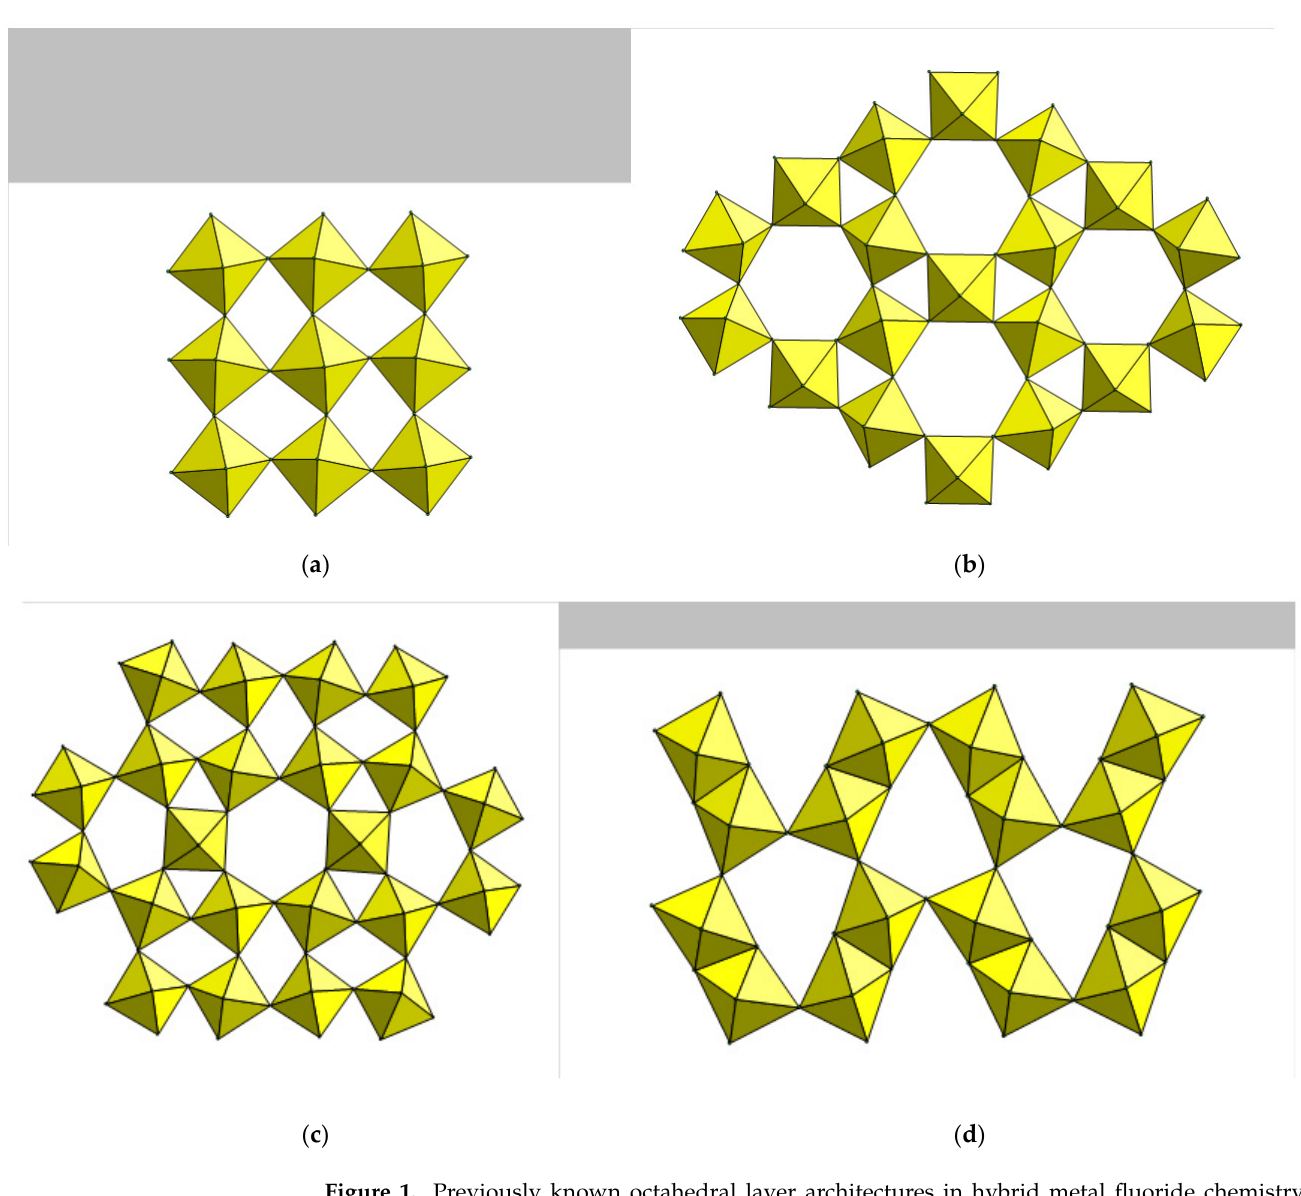
Figure 1. Previously known octahedral layer architectures in hybrid metal fluoride chemistry: ( a ) perovskite-like layer in [H 2 en ]MnF 4 ( b ) kagome layer in (NH 4 ) 2 [H ea ]V 3 F 12 ( c ) complex layer in [H 2 en ]ScF 4 , containing 3-, 4-, 5- and 6-rings ( d ) edge- and corner-sharing layer in [H 2 pipz ] 2 Mn 4 F 16 . Note that all four structures are essentially based on [ M F 4 ] ∞ layers.